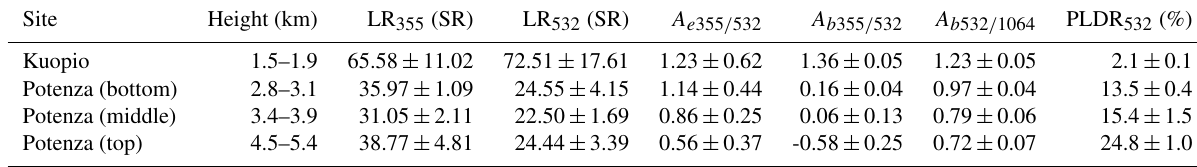
Table 3. Mean values of the intensive optical properties of aerosol layers observed on 30 July 2015 over Kuopio and Potenza. Site Height (km) LR 355 (SR) Kuopio Potenza (bottom) Potenza